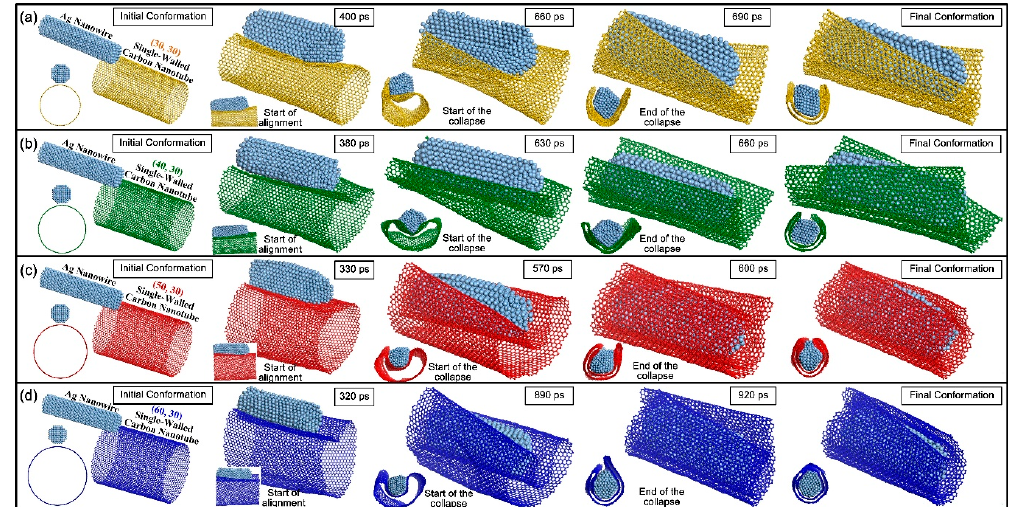
Figure 2. The evolution of atomic configurations between AgNW and single-walled nanotubes (SWNTs) with different chiralities of ( a ) (30, 30), ( b ) (40, 30), ( c ) (50, 30) and ( d ) (60, 30) at 500 K, respectively.